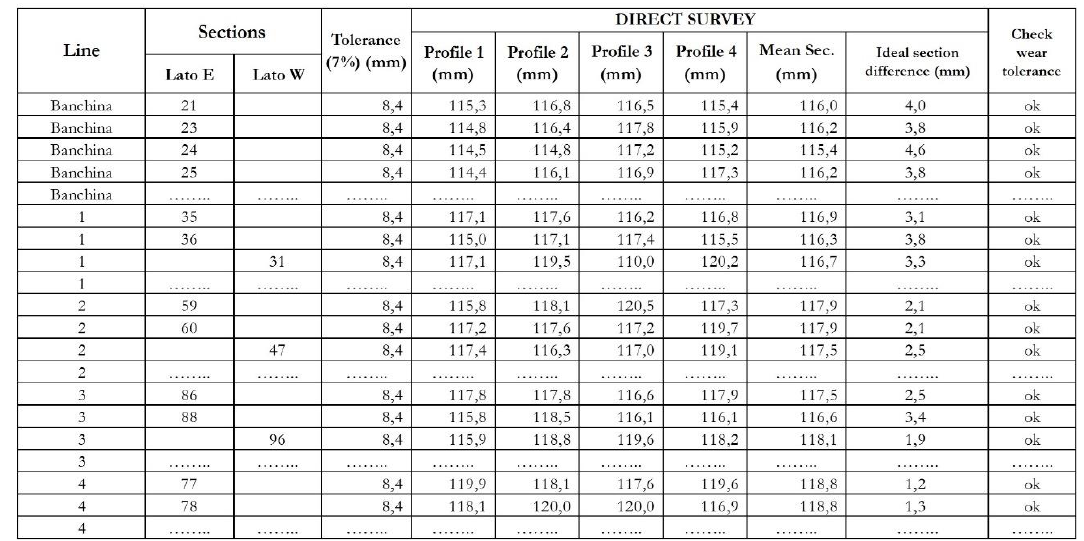
Figure 12. Results of the verification binary wear and control with calibre